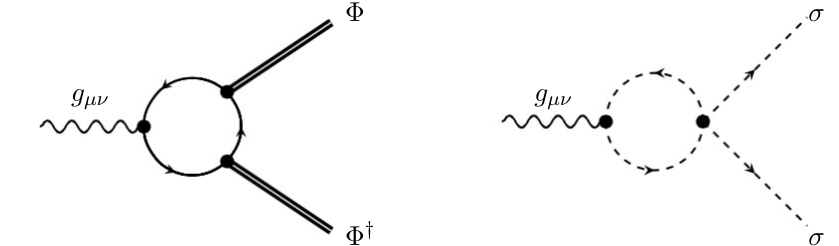
Figure 5 . Non-minimal couplings to gravity for the composite (cid:12)eld (cid:8) (double solid line) induced from internal fermion loops (single solid line) on the lefthand side. The running of the non-minimal coupling parameter $ at one-loop is due to the presence of the 1 PI diagram on the righthand side involving the (radial) in(cid:13)adron (cid:27)